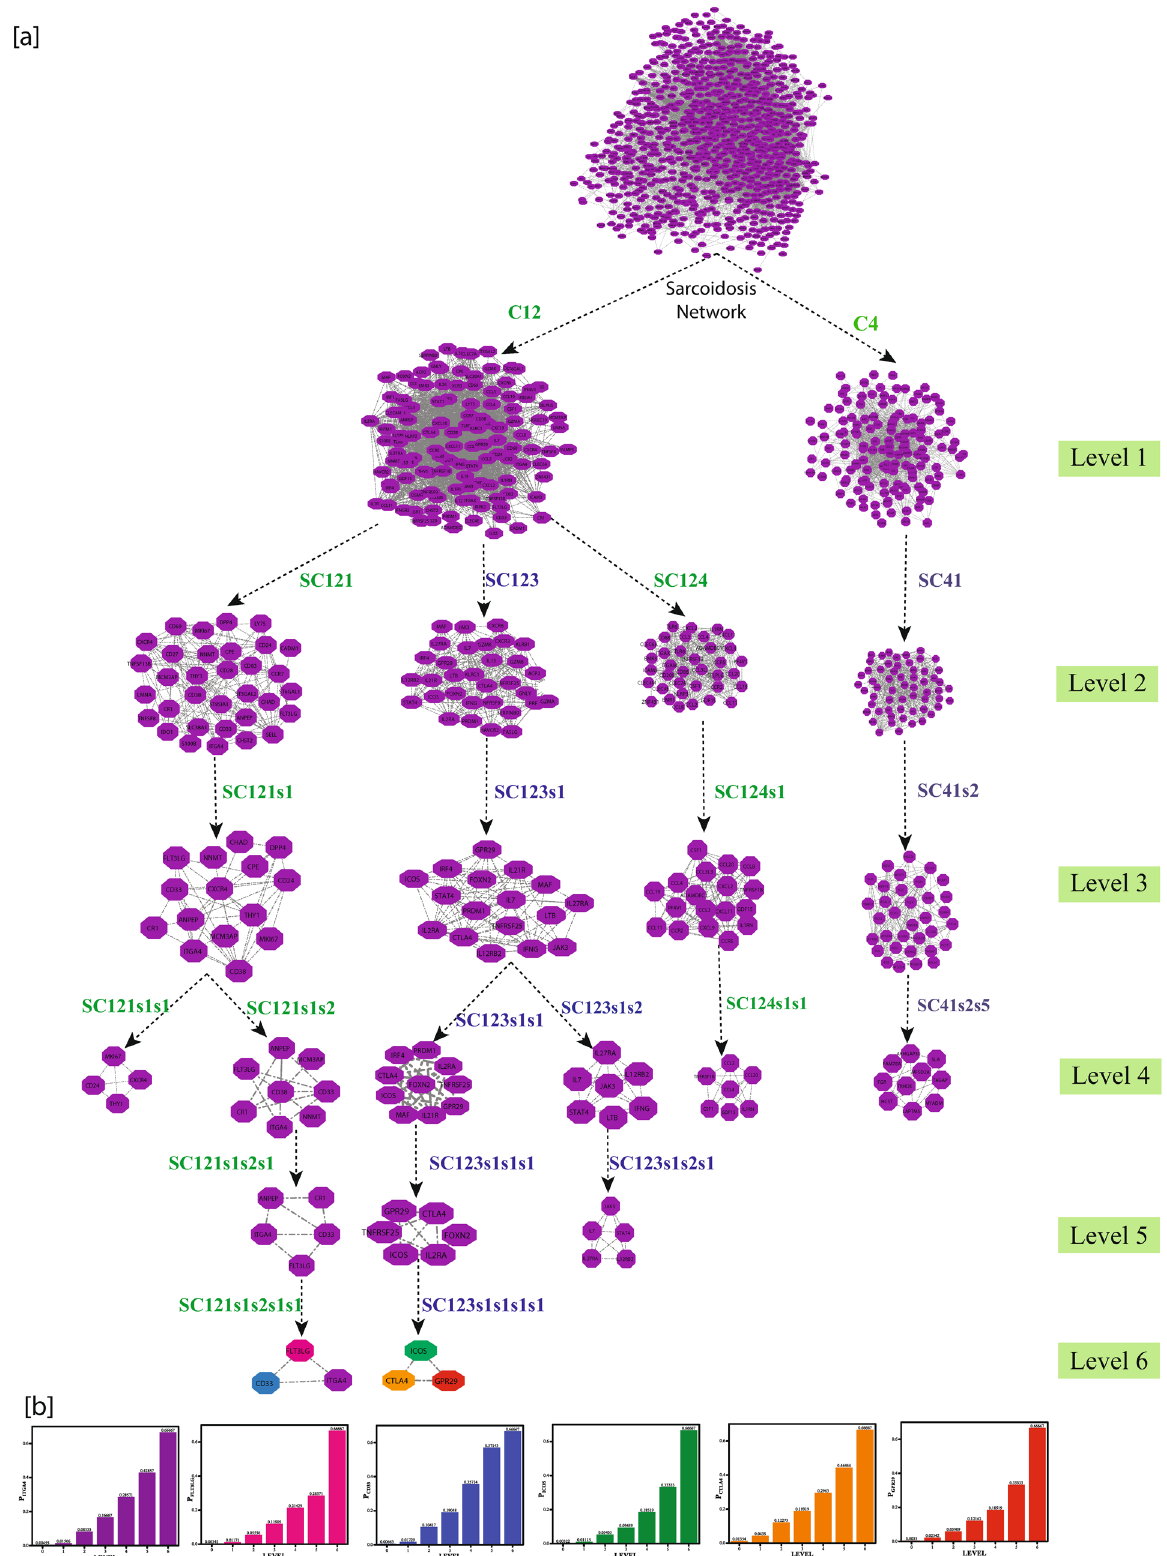
Figure 6. ( a ) The modular path of key regulators starting from the primary network to the motif levels. ( b ) The probability distribution of the key regulators as a function of the